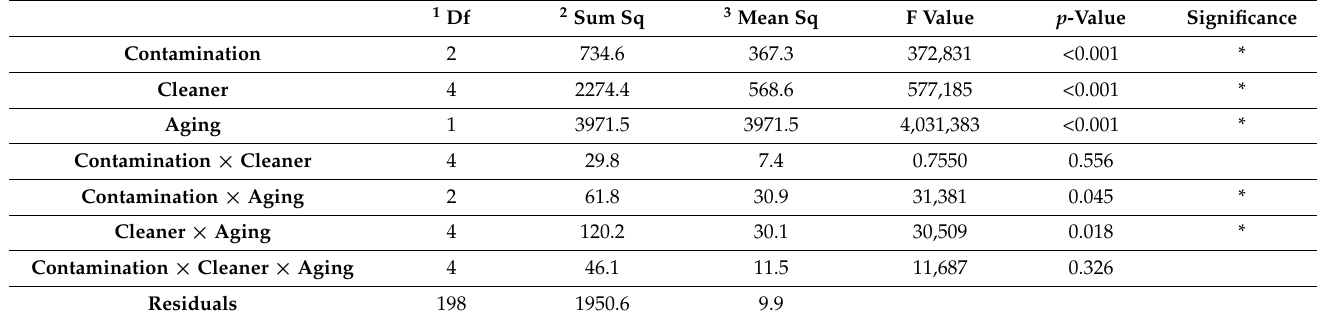
Table 4. Three-way ANOVA statistical analysis including first-, second-, and third-order interactions. 1 Df